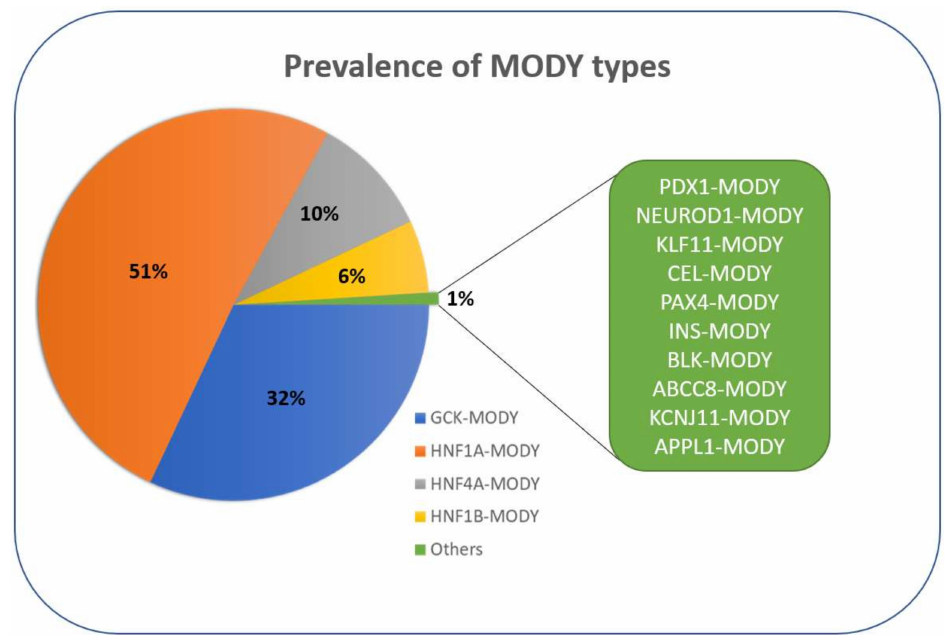
Figure 3. Prevalence of MODY types in some European countries. Table 1. Current MODY subtypes—gene function, clinical manifestation and